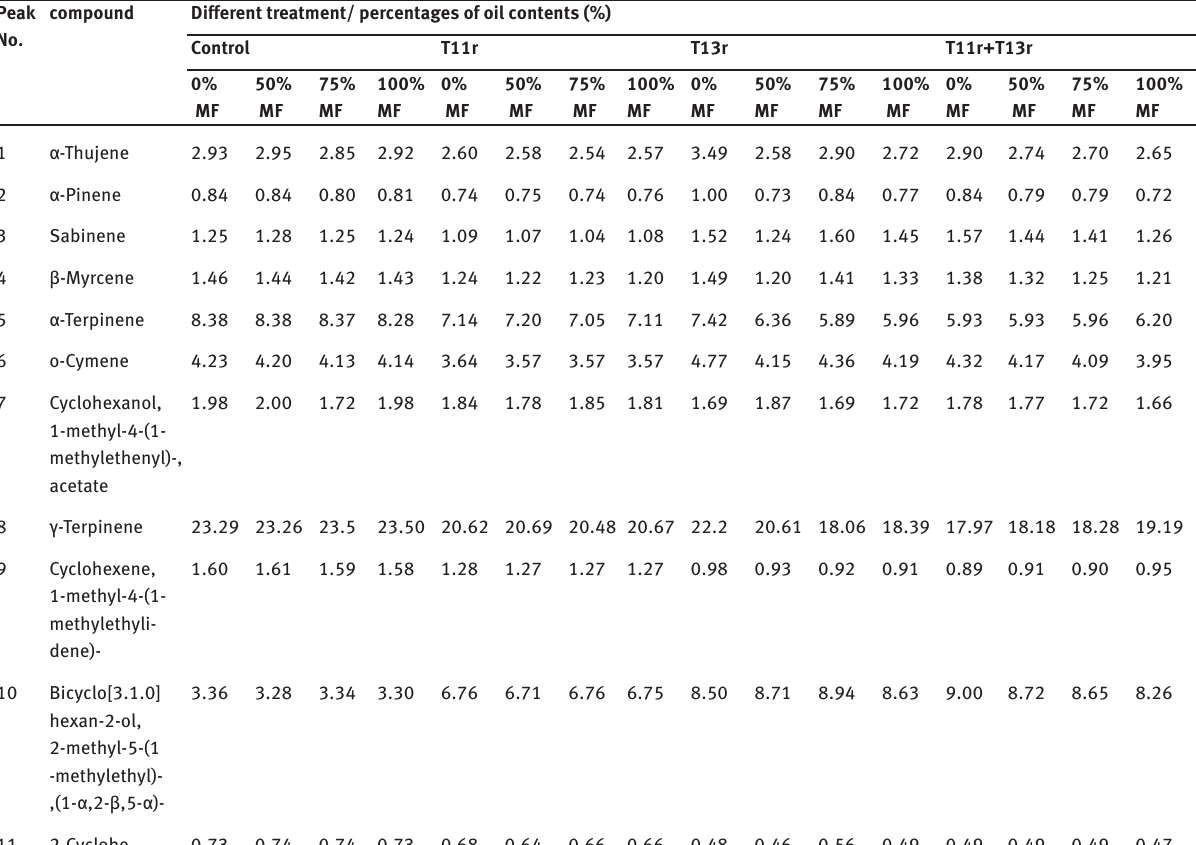
Table 7: List of compounds and their percentages existing in the extracted oil from T. vulgaris plant treated or not with bacterial endophytes (T11r, T13r, and their consortium) under different mineral fertilization